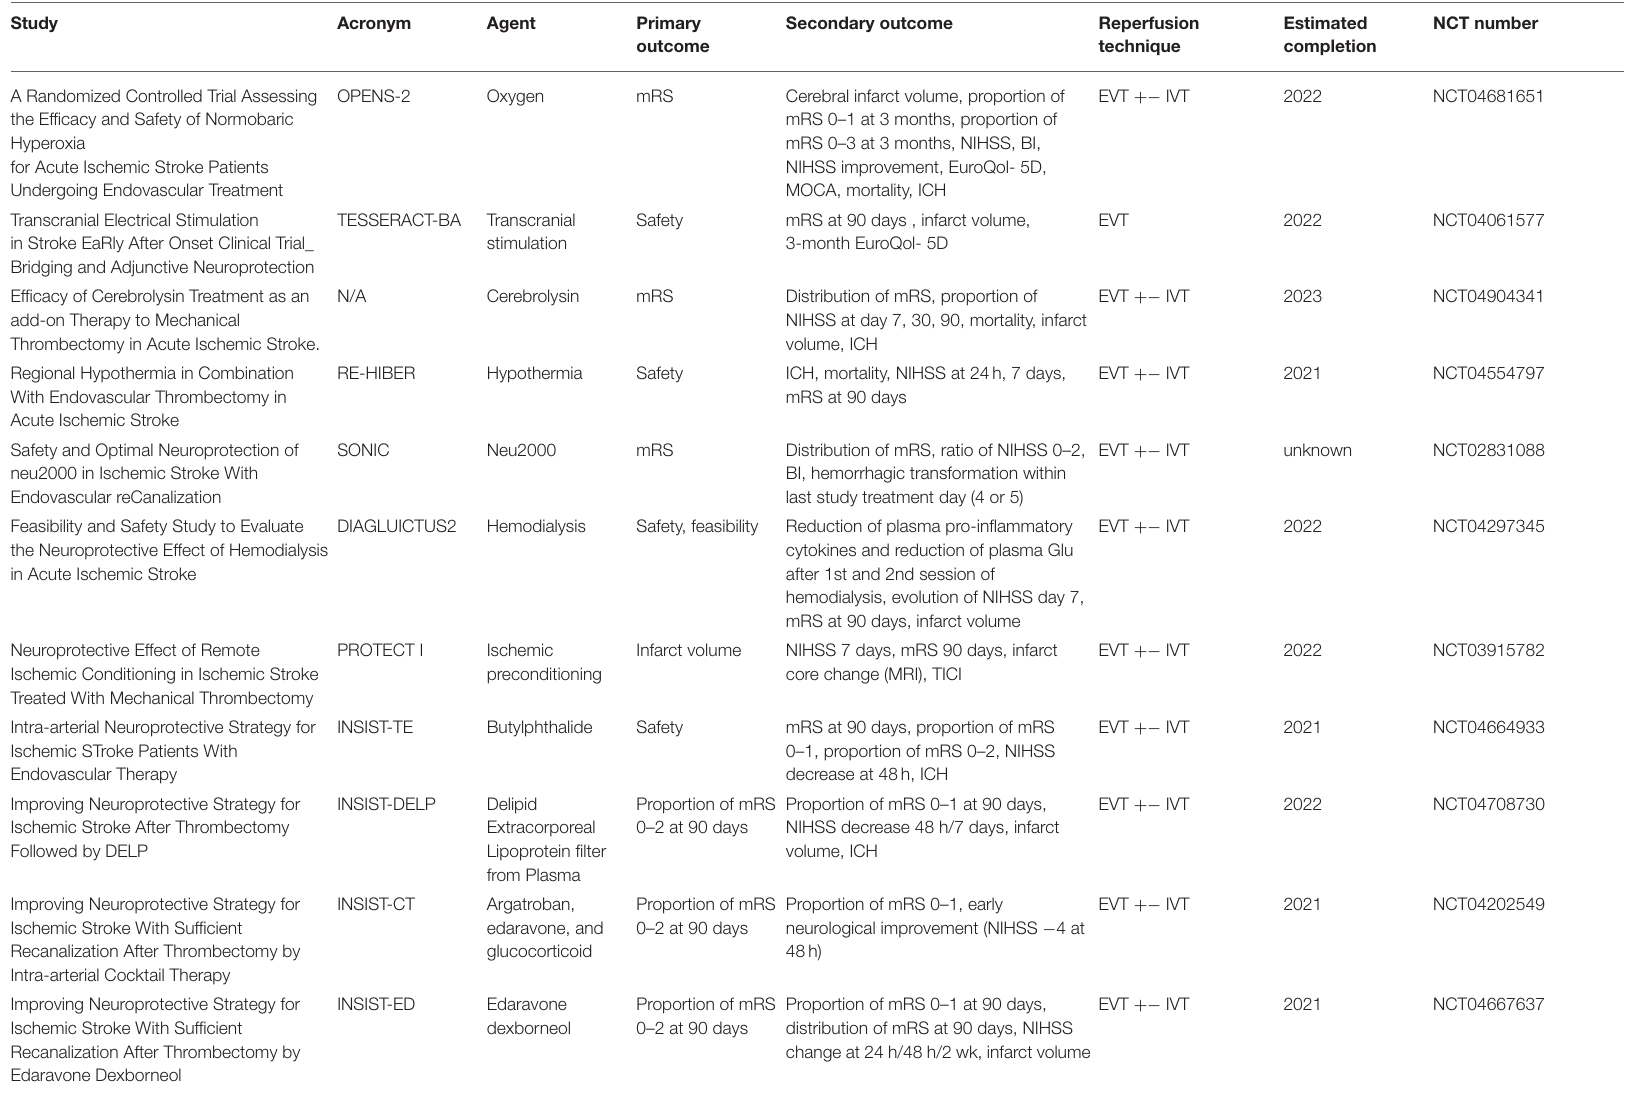
TABLE 4 | Current trials combining neuroprotection and